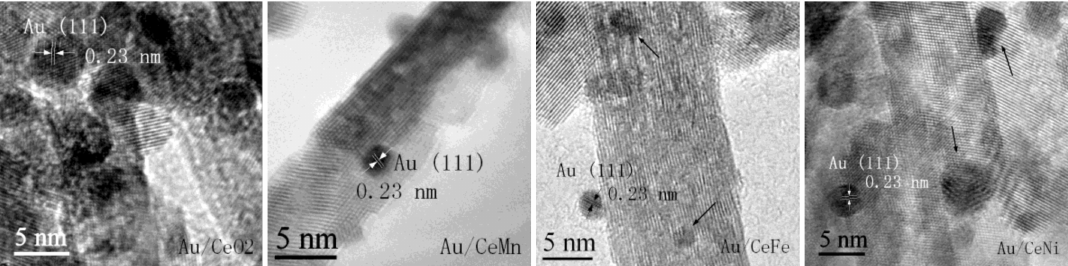
Figure 3. HRTEM images of Au catalysts supported on CeO 2 and CeM mixed oxides with different dopants (Au/CeO 2 ; Au/CeMn; Au/CeFe;